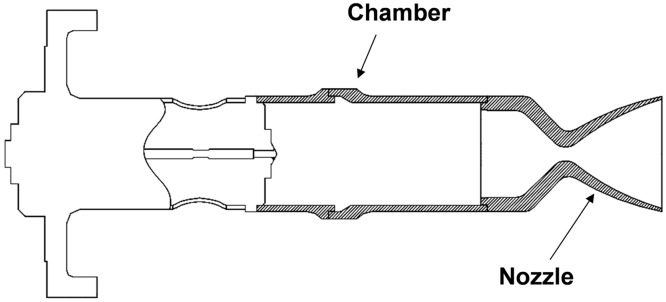
Small thruster configuration [10,16].